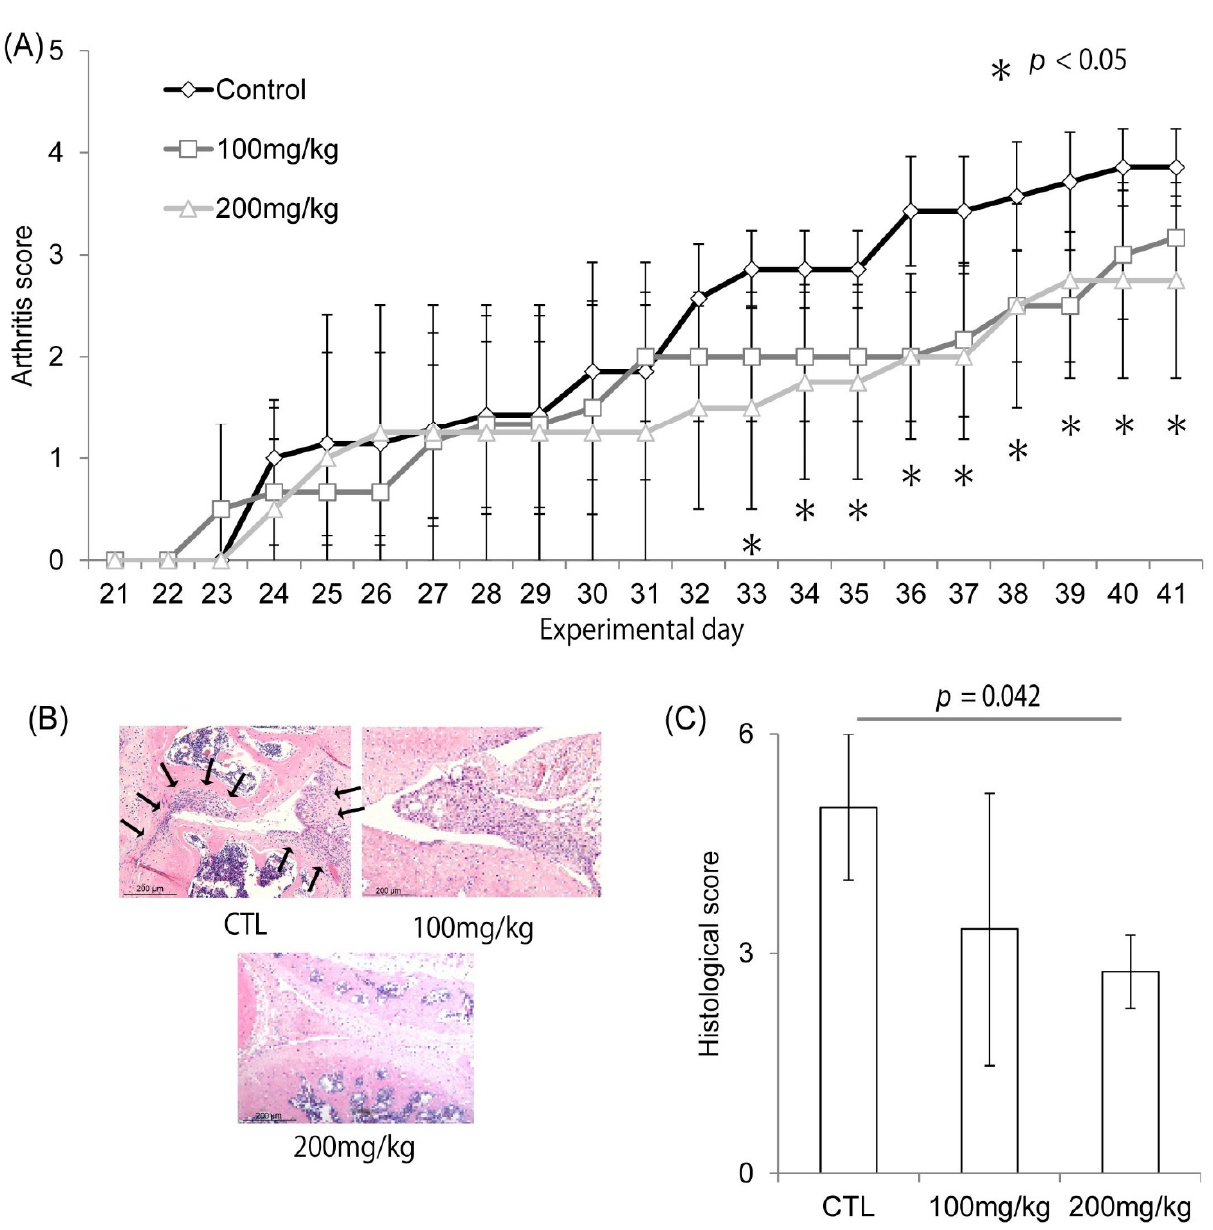
Figure 4. Effects of Ipriflavone on the progression of arthritis in CIA mouse model. ( A – C ) Effects of Ipriflavone on joint swelling. ( A ) Time course of arthritis score of paws with or without Ipriflavone treatment (CTL, 100 mg/kg, or 200 mg/kg, respectively) * p < 0.05. ( B , C ) Representative HE staining image of tissue section ( B ) and histological score ( C ) of knee joints at day 42 of CIA mice model with or without 100 mg/kg Ipriflavone treatment. Arrows depict the invading inflammatory cells in B. Bar in B = 200 μ m.